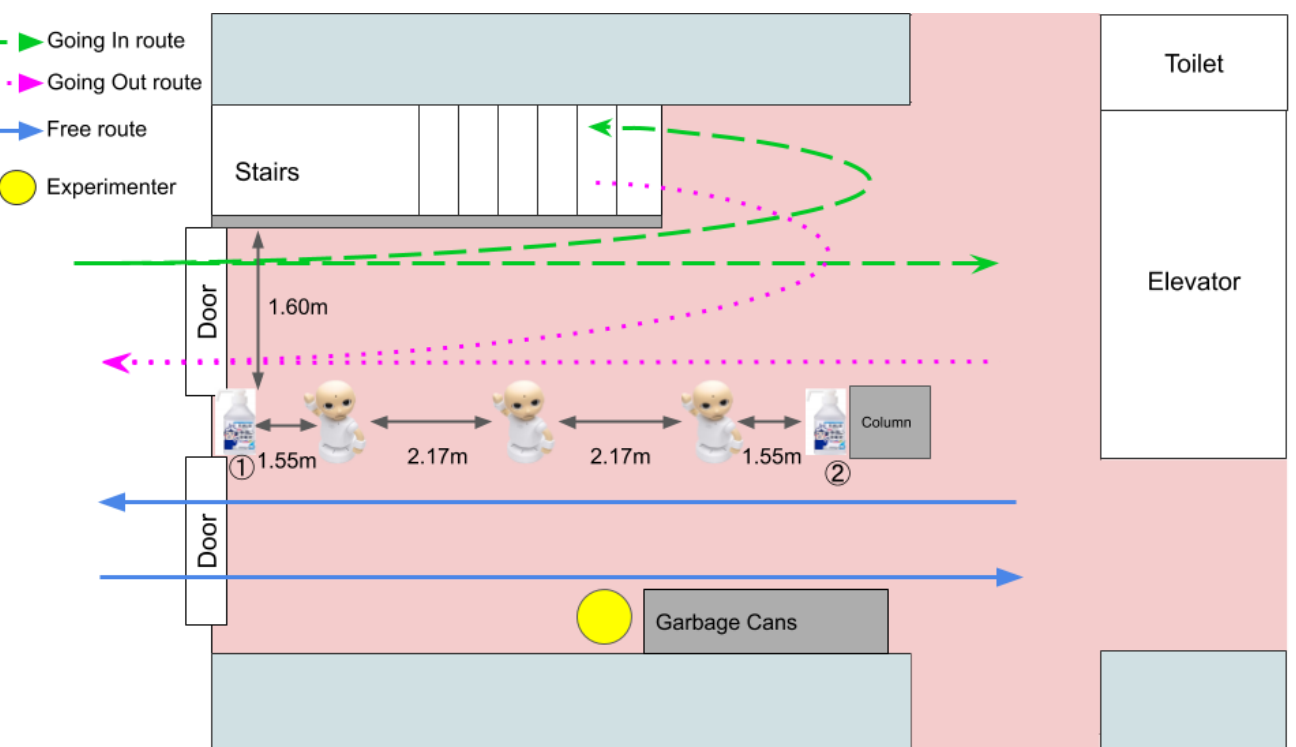
Figure 6. Map of the D entrance of the building of the Graduate School of Science Engineering in Osaka University with hand sanitizer dispensers and three robots in place. The distances noted are not to scale and were measured before the start of every experiment. The arrows represent the different routes a passerby might take during the